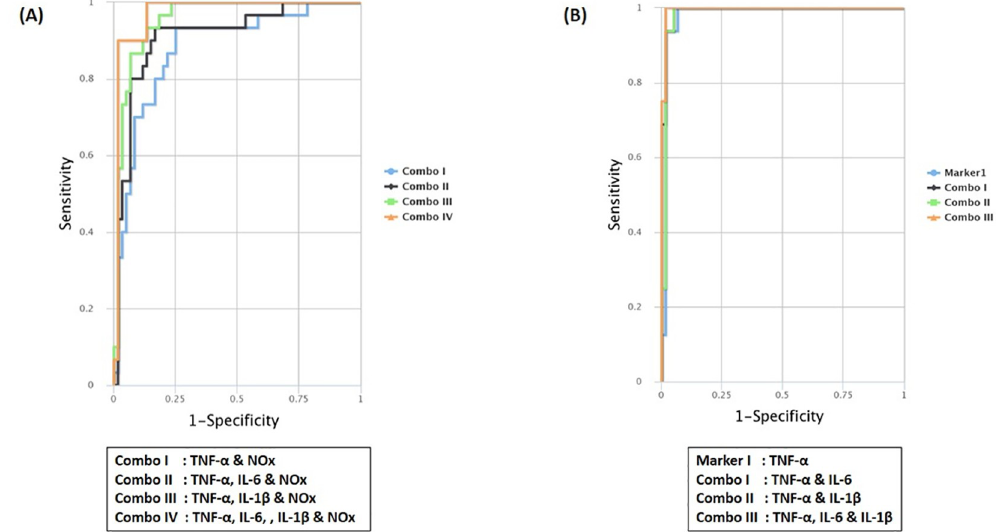
Fig 4. Multiple Receiver Operating Characteristic (ROC) curves as a function of sensitivity vs 1-specificity to compare the performance of markers and combos for (A) Primary Knee Osteoarthritis (pKOA), (B) Secondary Knee Osteoarthritis